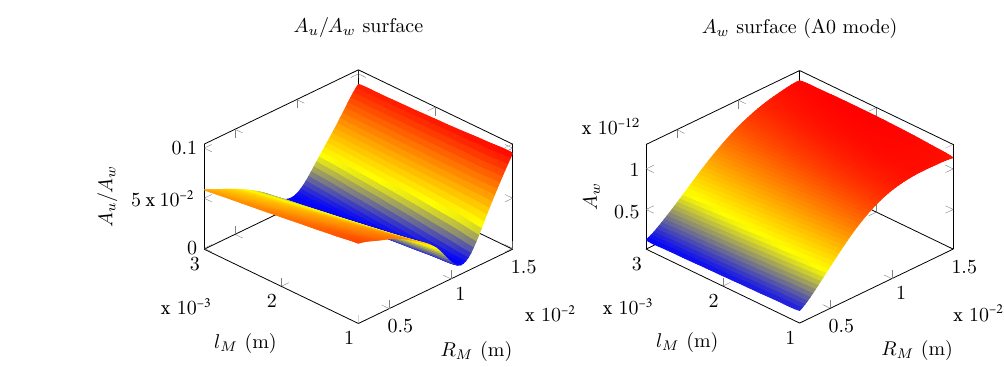
Figure 11. A u /A w and A w surfaces predicted with the RBFNN with nonexact interpolation.